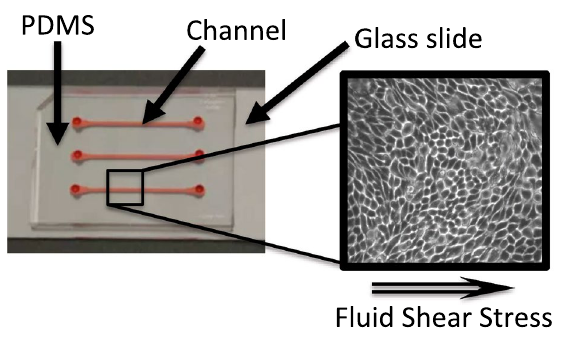
Figure 1. Aerial perspective image of linear kidney proximal tubule device. The linear device is assembled on a microscope glass slide with polydimethylsiloxane (PDMS) creating three of the channel walls (red) allowing three independent channels for cellular experiments. Dimensions of cell culture channels (highlighted in red) are 500 µm × 100 µm × 1 cm (width × height ×